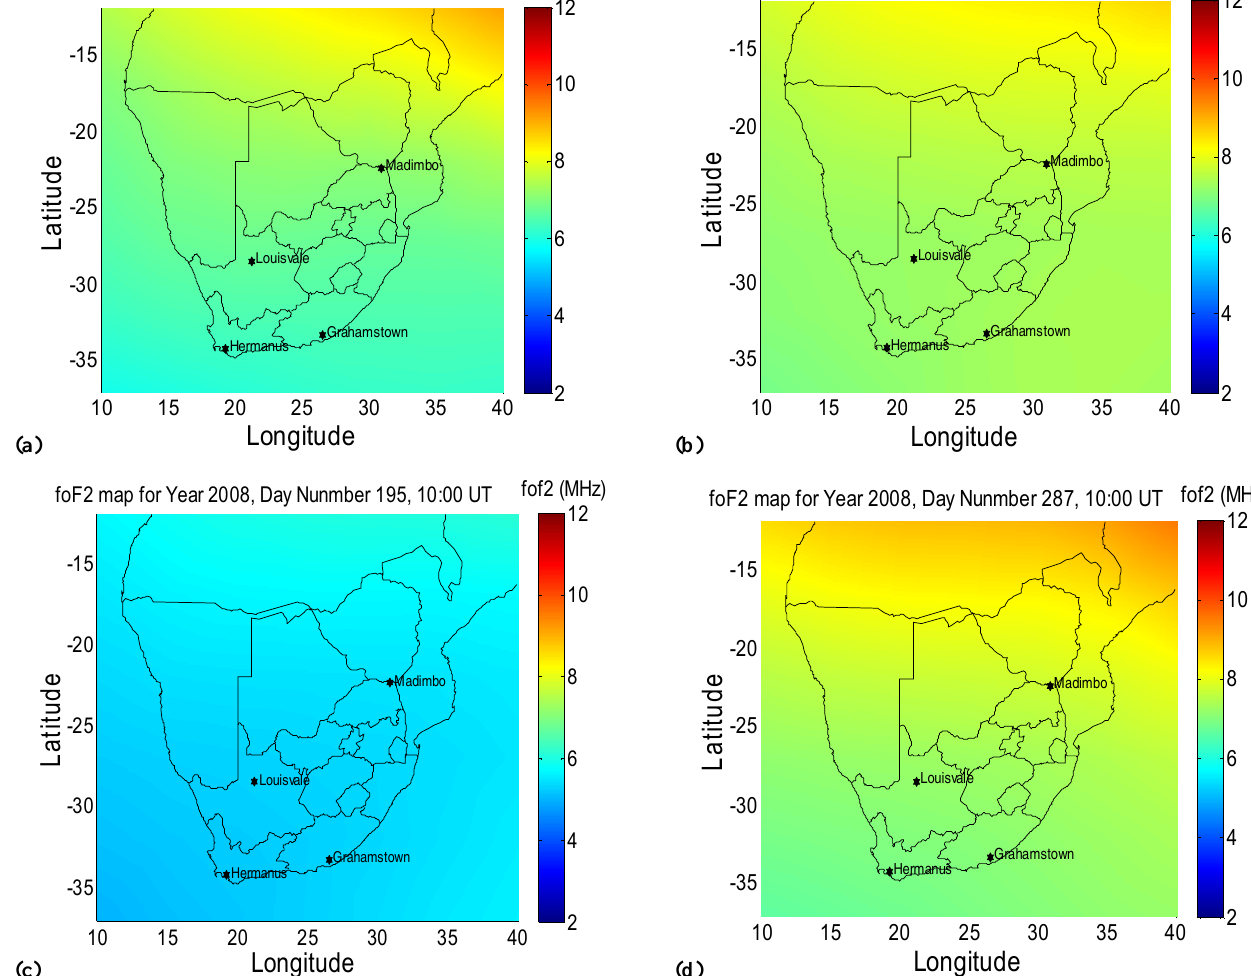
Fig. 4. Variations in fo F2 over South Africa for (a) a summer day, (b) an autumn day, (c) a winter day and (d) a spring